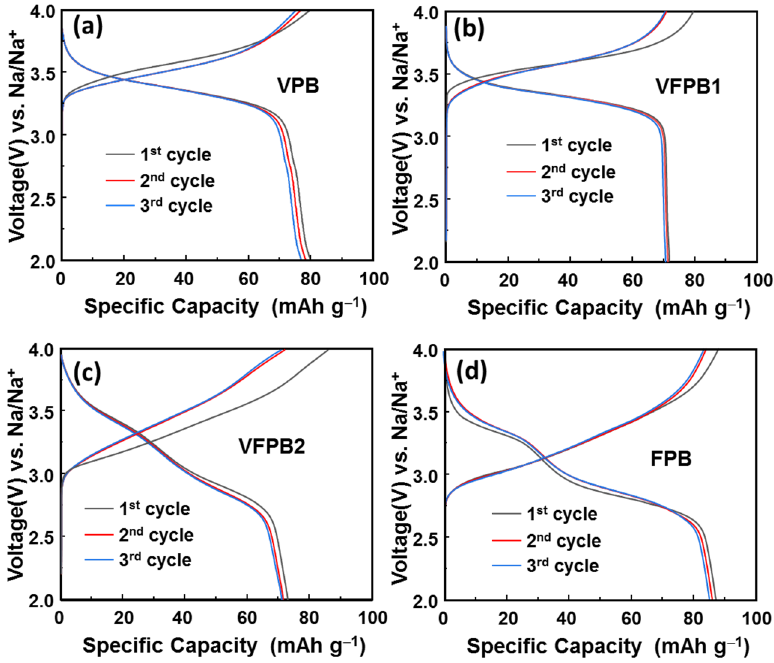
Figure 4. Initial voltage profiles of ( a ) VPB, ( b ) VFPB1, ( c ) VFPB2, and ( d ) FPB cathodes.